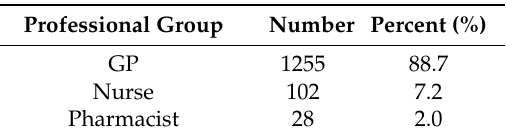
Table 1. Profession of